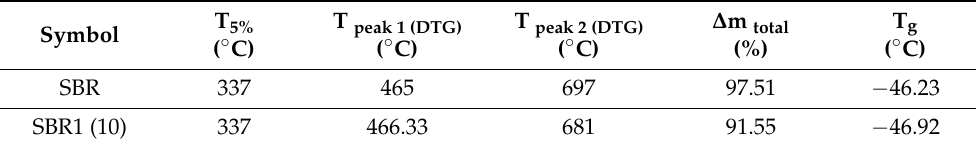
Figure 8. Comparative analysis of DSC results: unfilled SBR (black curve) and SBR10 (10 phr of BCA, red curve). Table 8. Thermal characteristics of SBR and SBR1